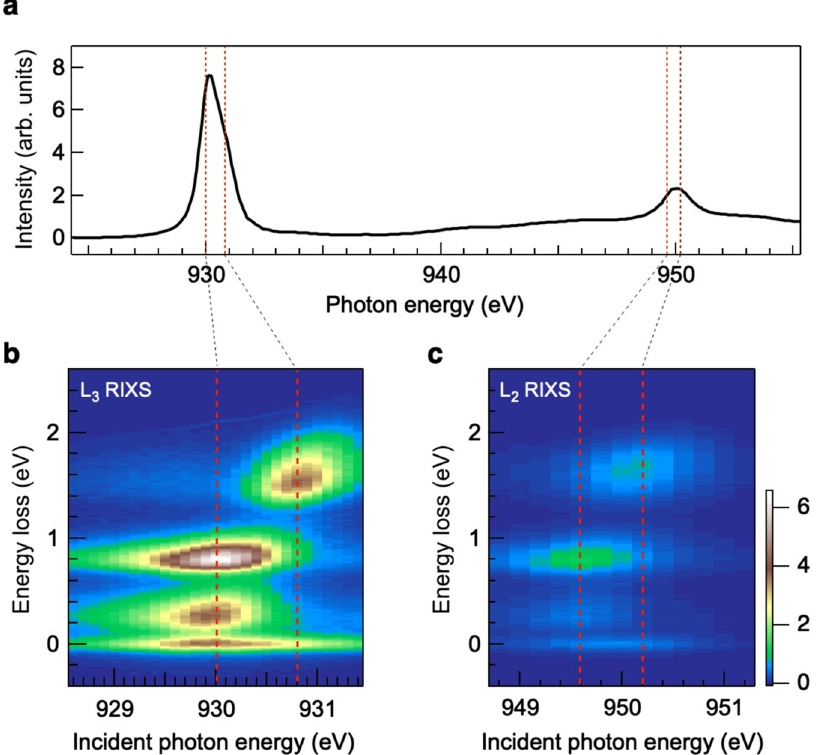
Fig. 2 RIXS intensity distribution maps of CuAl 2 O 4 in the plane of energy loss vs. incident photon energy. a Cu L -edge XAS spectrum measured with total electron yield. b & c RIXS intensity maps measured around Cu L 3 and L 2 edges, respectively. The vertical red dashed lines indicate RIXS features from tetrahedral and octahedral Cu 2 + , corresponding to the absorption energies of the XAS spectrum shown in ( a ), i.e., 930 & 949.6 eV and 930.8 & 950.2 eV, respectively. All spectra were recorded at room temperature with π -polarized incident